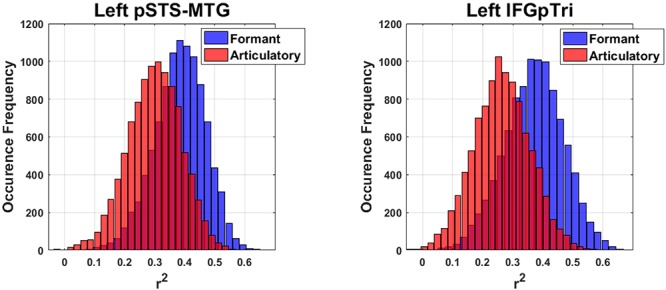
Bootstrap-based performance comparison between the articulatory and formant models, in regions surviving Bonferroni correction (C.I.: 5–95th of the distribution obtained by computing their difference).